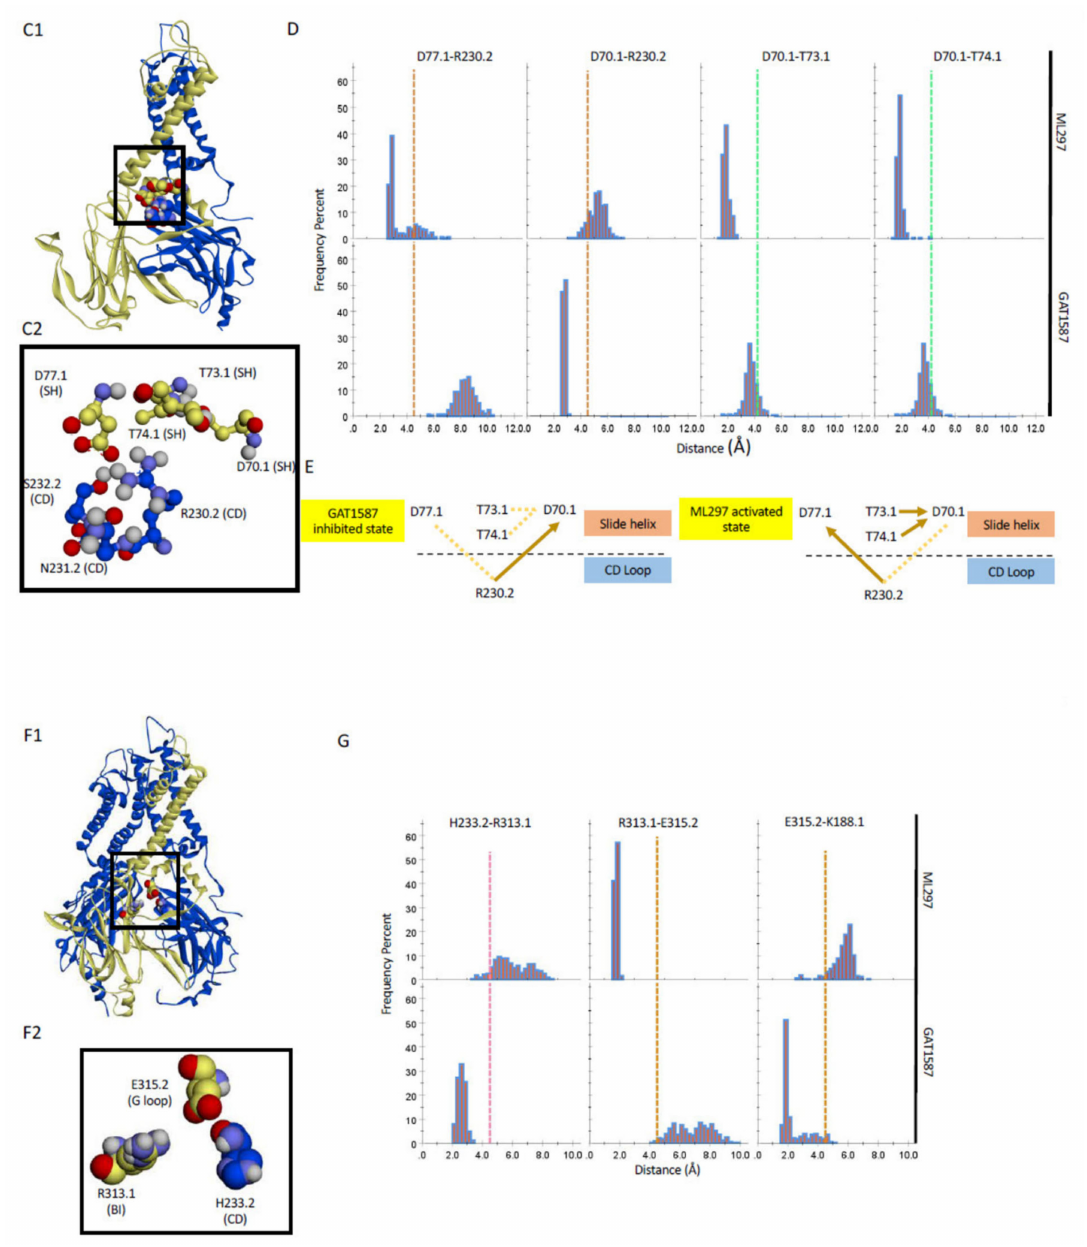
Figure 5. The ML297-induced SH movement, as a result of the TM1 movement, drives changes in the CD loop interactions causing stabilization of the G-loop in the open conformation through its residue GIRK2-E315.2 liberating K188.1 that coordinates PIP 2 to stabilize the HBC gate in the open conformation. ( A ) A model of how TM1 modulates the slide helix ( A1 ) and a quantification of these effects ( A2 ). ( B ) Relative movements of the activated and inhibited SH regions. ( C ) Protein structure ( C1 ) with residues that link the SH to the CD loop ( C2 ). ( D ) Distance distributions of key residues that drive the channel into the active state. Dark yellow denotes charge–charge interactions with an upper cutoff of 4.0 angstroms. Light green denotes dipole charge interactions with an upper cut off of 4.0 angstroms. ( E ) Schematic outline of the changes in key residue interactions. ( F ) Protein structure ( F1 ) with residues that link the SH to the CD loop ( F2 ). ( G ) Distance distributions of residues that drive the channel into the active state. Dark yellow denotes charge–charge interactions with an upper cutoff of 4.0 angstroms. Pink denotes dipole charge interactions with an upper cutoff of 4.0